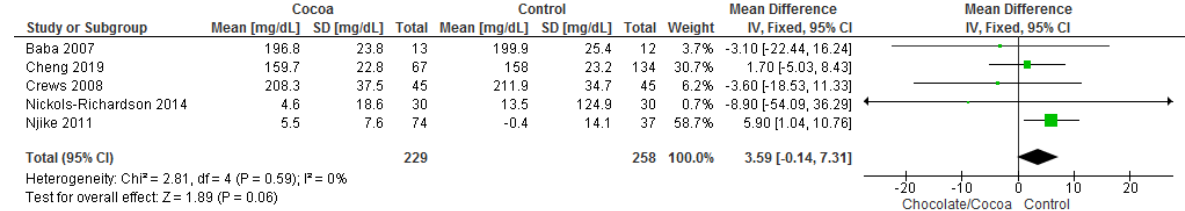
Figure 5. Forest plot of comparison: chocolate versus control, with the outcome - total cholesterol (mg/dL).